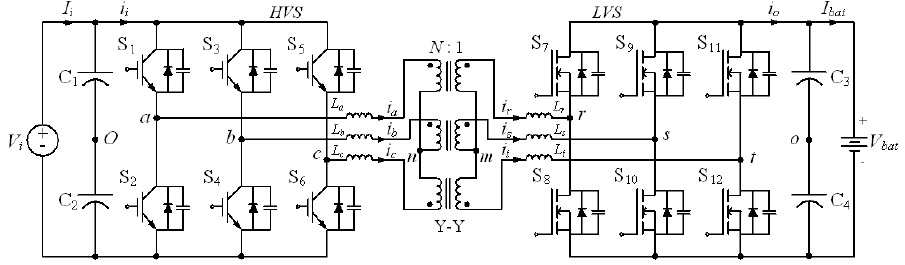
Figure 1. The bidirectional three ‐ phase DAB DC/DC converter.